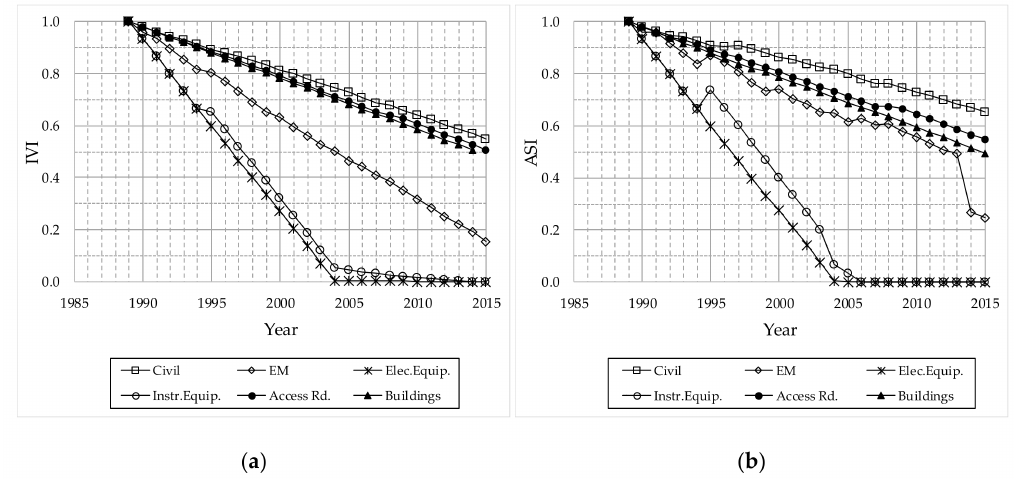
Figure 4. Element condition assessment of Asset 2: ( a ) IVI index; ( b ) ASI index.